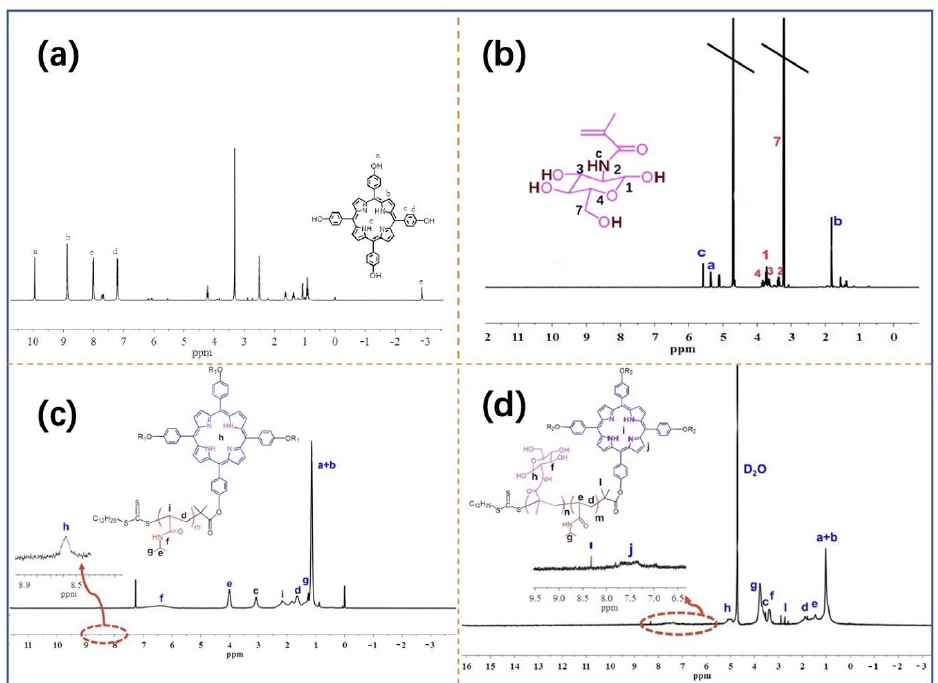
Figure 1. FTIR spectra of MAGA, THPP-(PNIPAM) 4 and THPP-(PNIPAM- b -P MA GA) 4 .